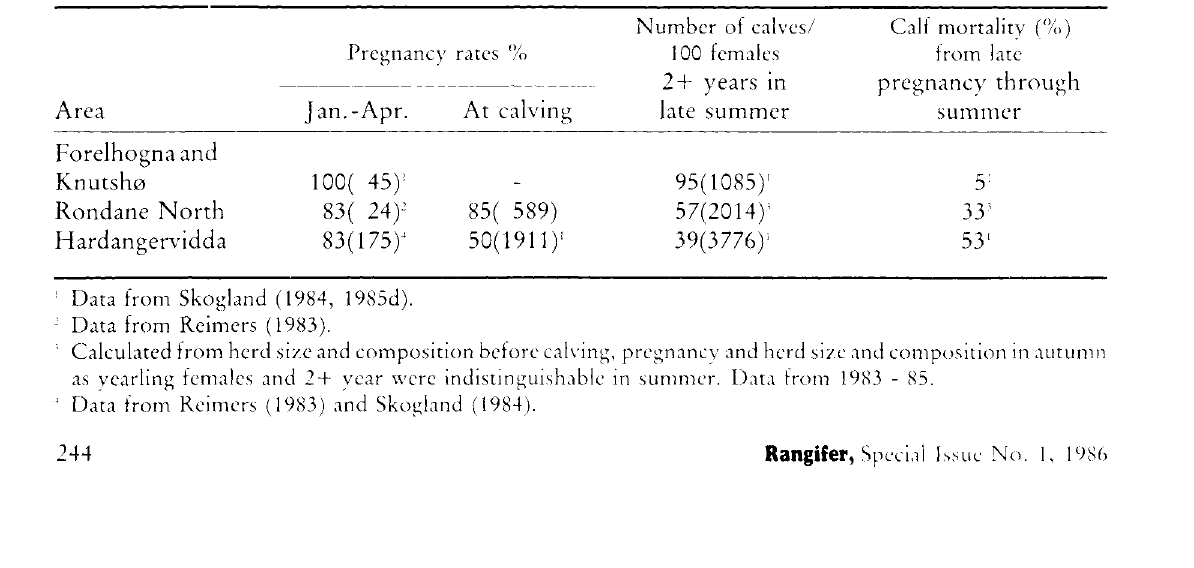
Table 4. Pregnancy rates among 1-year or older wild reindeer and calf mortality. Sample size in paranthesis. Number of calves/ Calf mortality (%) Pregnancy rates % 100 females from late 24- years